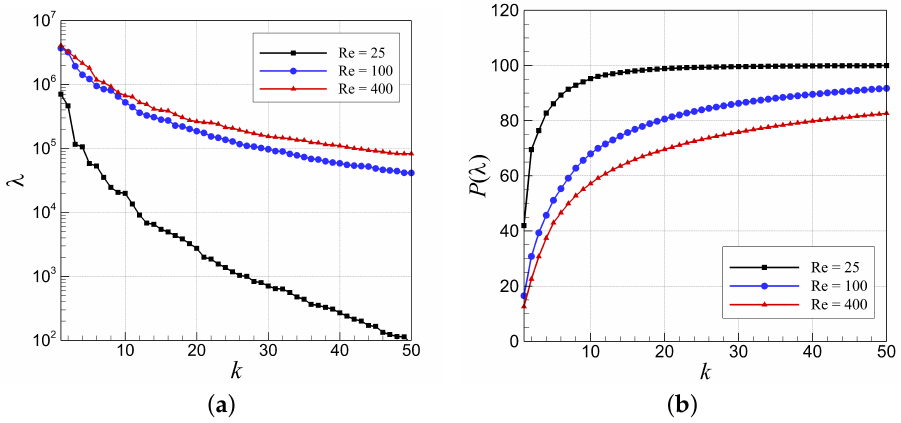
Figure 3. Proper orthogonal decomposition (POD) analysis by using 900 equally distributed snapshots for Re = 25,100,400: ( a ) Eigenvalue spectrum of the correlation matrix, A ; and ( b ) Eigenvalue percentage energy accumulation with respect to modal index.